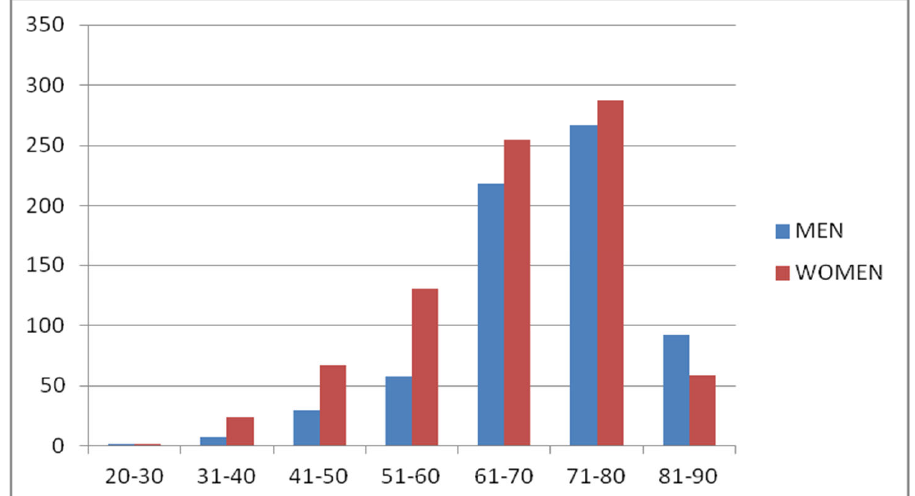
Figure 1. Age distribution of glaucoma patients based on gender.